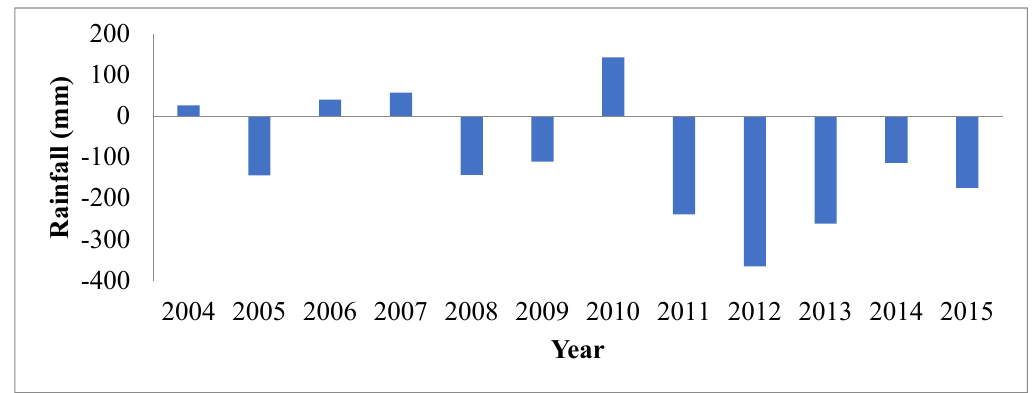
Figure 3. Annual rainfall (mm) anomalies in Ejura-Sekyedumase Municipality (2004–2015); NB: average annual rainfall (1971–2000) for the municipality is 1430.0 mm.